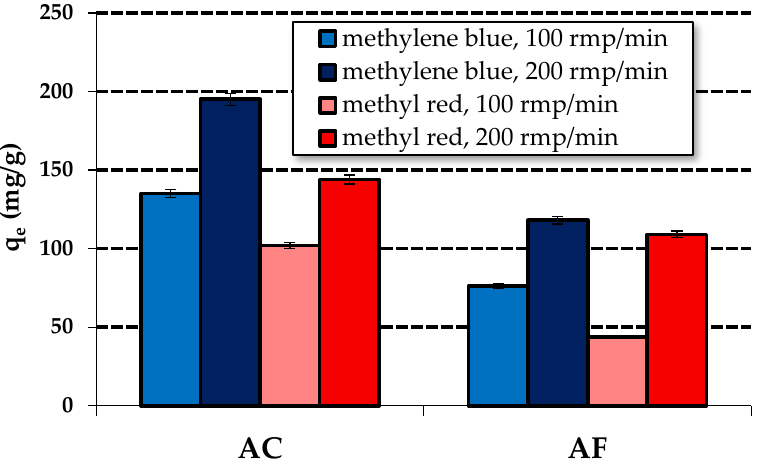
Figure 8. Effect of adsorption efficiency on the adsorption of methylene blue ( a )/methyl red ( b ) on activated carbon.